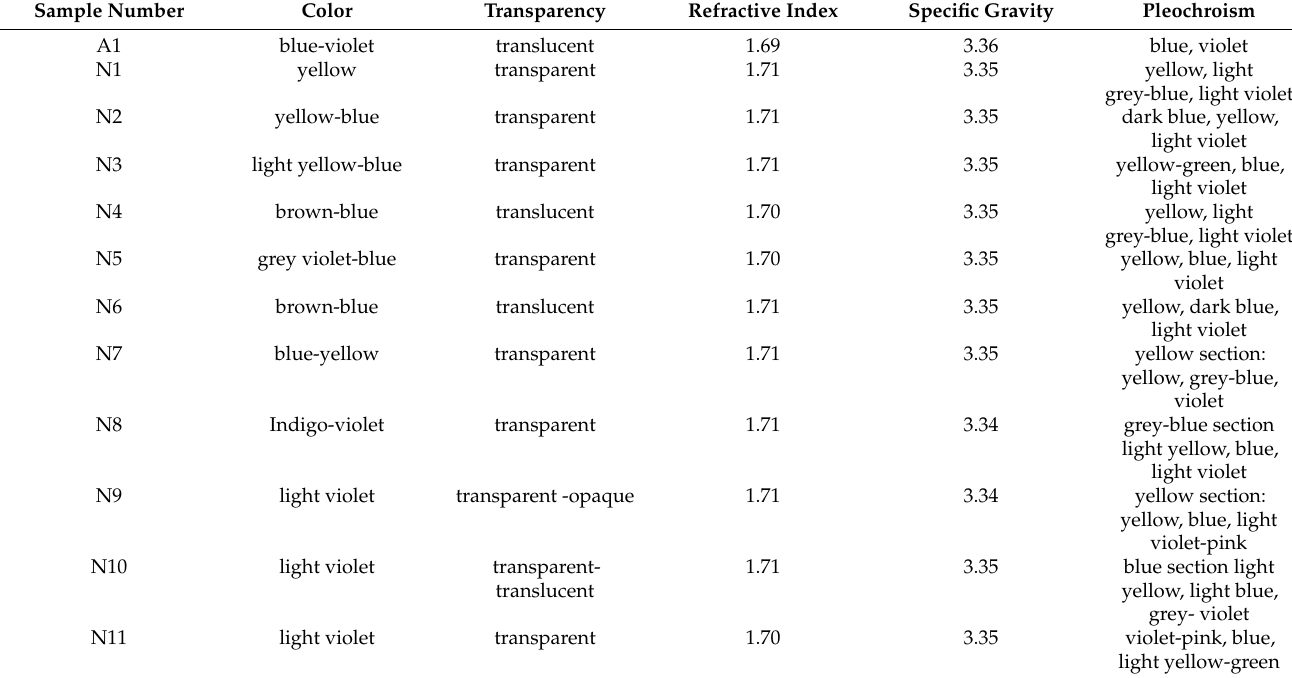
Figure 1. Twenty-two different samples of tanzanite. Table 1. Conventional gemological properties of tanzanite